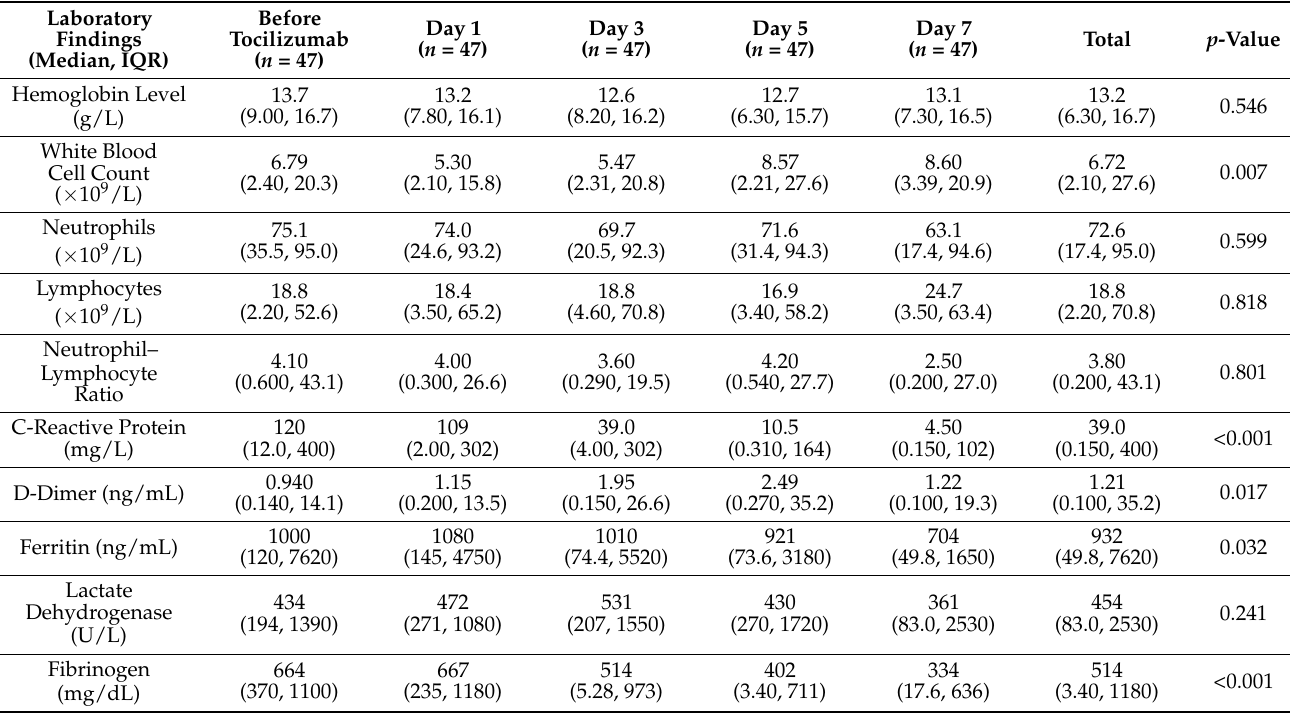
Table 3. Laboratory findings before and during Tocilizumab therapy among total population.